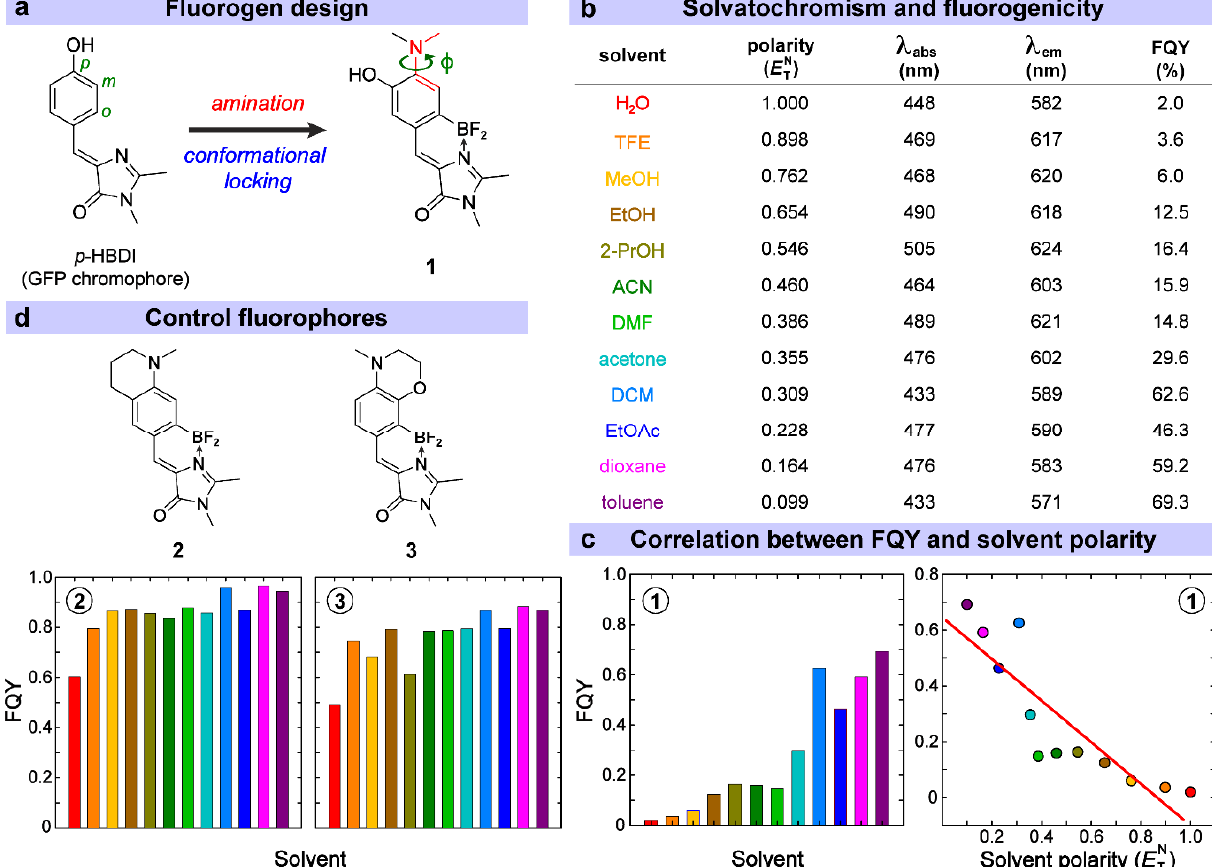
Figure 1. Rational design and photophysical properties of a GFP-derived fluorogen and control fluorophores. ( a ) Design of the fluorogenic compound 1 . ( b ) Solvatochromism and fluorogenicity of compound 1 in a variety of solvents. ( c ) Correlation between the observed FQY and solvent polarity. ( d ) Structures and FQYs of two control compounds 2 and 3 in the same solvents for direct comparison with compound 1 . The colors for various solvents in ( c , d ) are defined in ( b ).